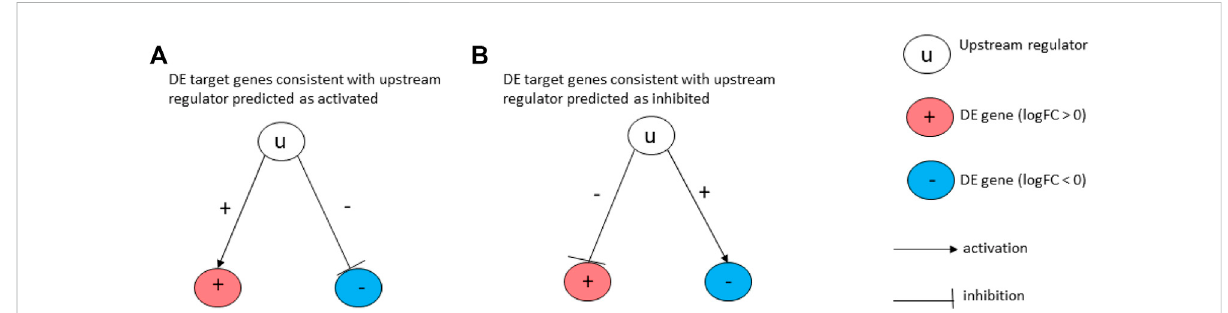
FIGURE 3 Target genes consistent with the hypothesis considered: In (A) , the signs of the DE genes shown in red (+) and blue ( − ) match the signs of their respective incoming edges, suggesting that the upstream regulator u is activated. In (B) , the signs of the DE genes shown in red (+) and blue ( − ) are opposite to the signs of their edges, suggesting that the upstream regulator u is